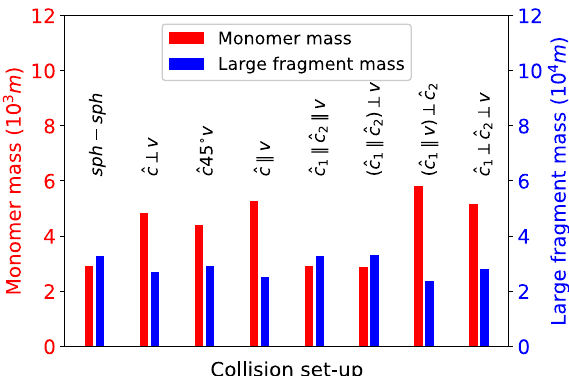
Figure 6. Dependence of the total mass of ejected monomers, N m , and the total mass of large fragments with sizes N ≥ 400 on the collision geometry, cf. Table